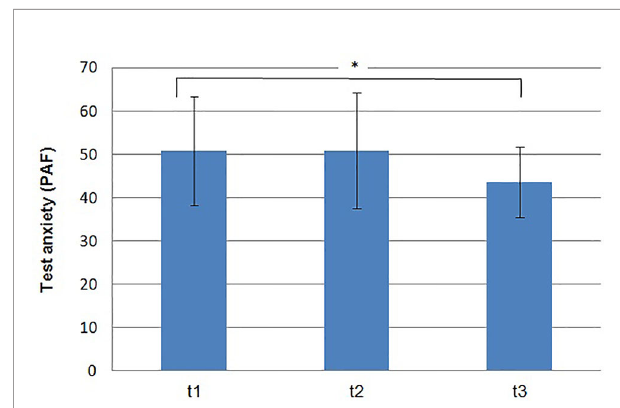
FIGURE 2 | Means and standard deviations of the test anxiety on pre- (t1) , post measurement (t2) and follow up (t3) . (*p < .05) .